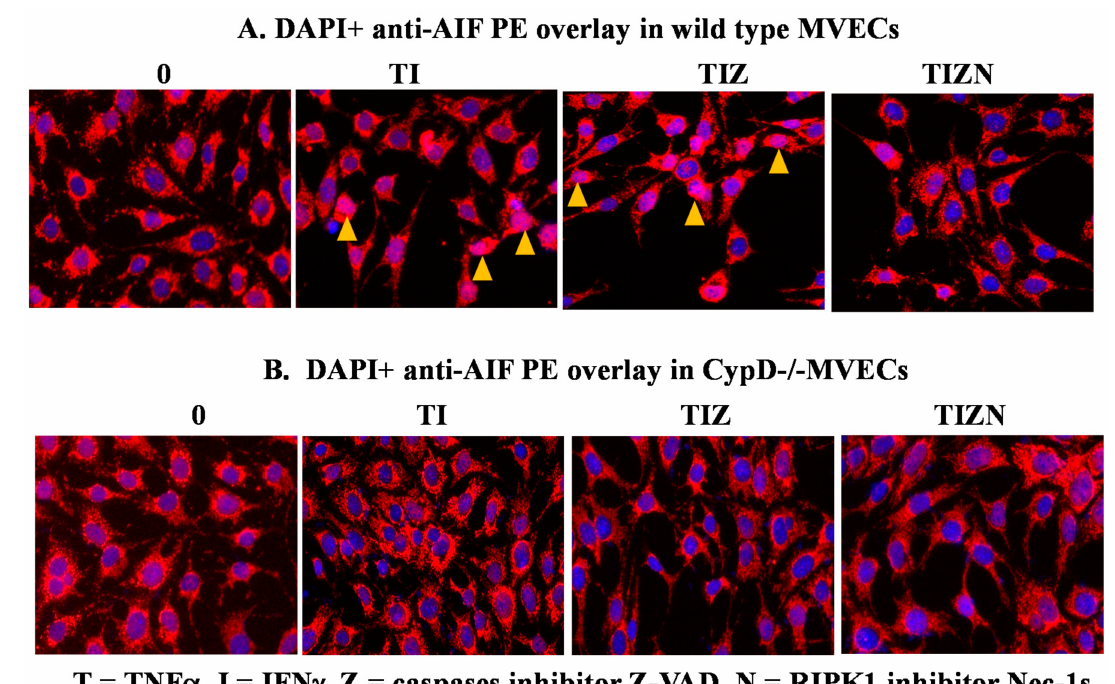
Figure 4. AIF translocation to the nucleus in necroptotic MVECs. Wild-type B6 MVECs ( A ) and CypD − / − MVECs ( B ) were subjected to the in vitro IRI treatment, as above. The MVECs were fixed with 4% formaldehyde solution after 24 h of reoxygenation and permeabilized with 0.1% Triton X-100. The cells were incubated with antimurine AIF antibody, followed by anti-rabbit PE-conjugated antibody. The nucleus was stained with 300-nM DAPI. Nuclear AIF staining (pink color) is pointed to by arrows. Images were captured under 200 times magnification under fluorescent microscopy. The same experiment was repeated at least 3 times. Representative cell images are